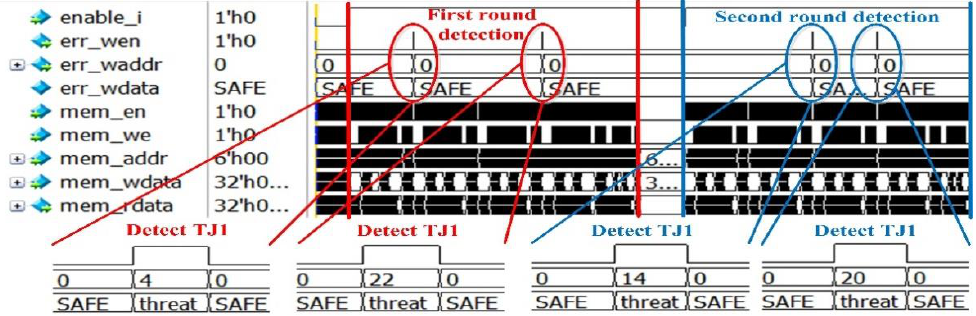
Figure 10. Detection result for HT1.